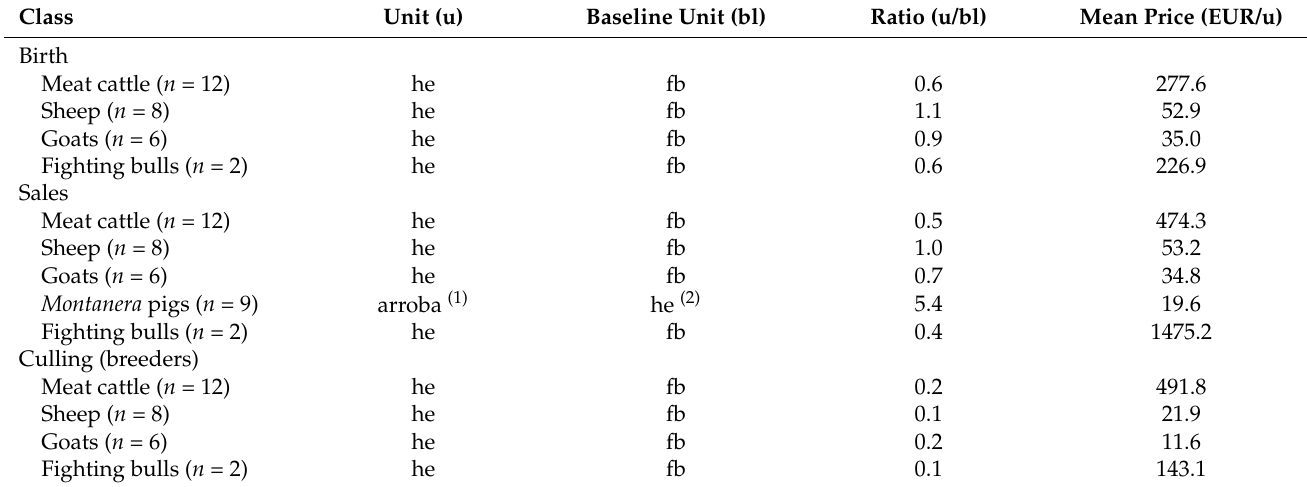
Table 4. Livestock yield ratios and prices for large privately owned case-study dehesas in Andalusia